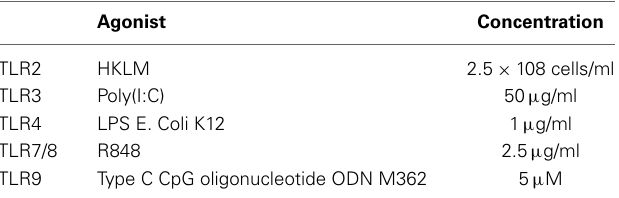
Table 2 | TLR agonists used for dM and dNK cell stimulation.